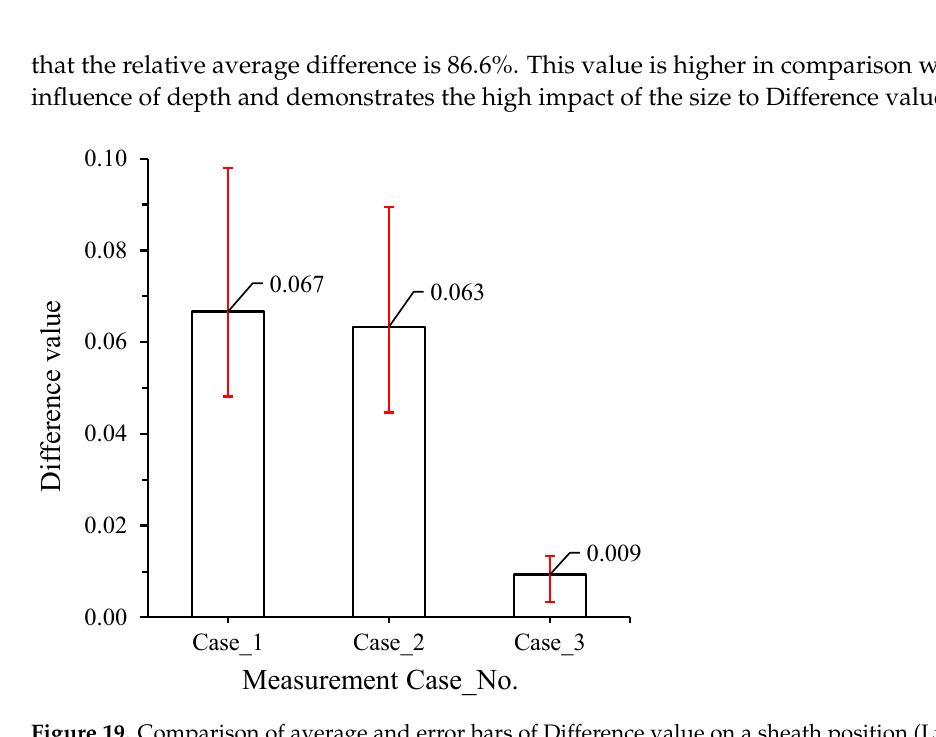
Figure 19. Comparison of average and error bars of Difference value on a sheath position (Line_06).